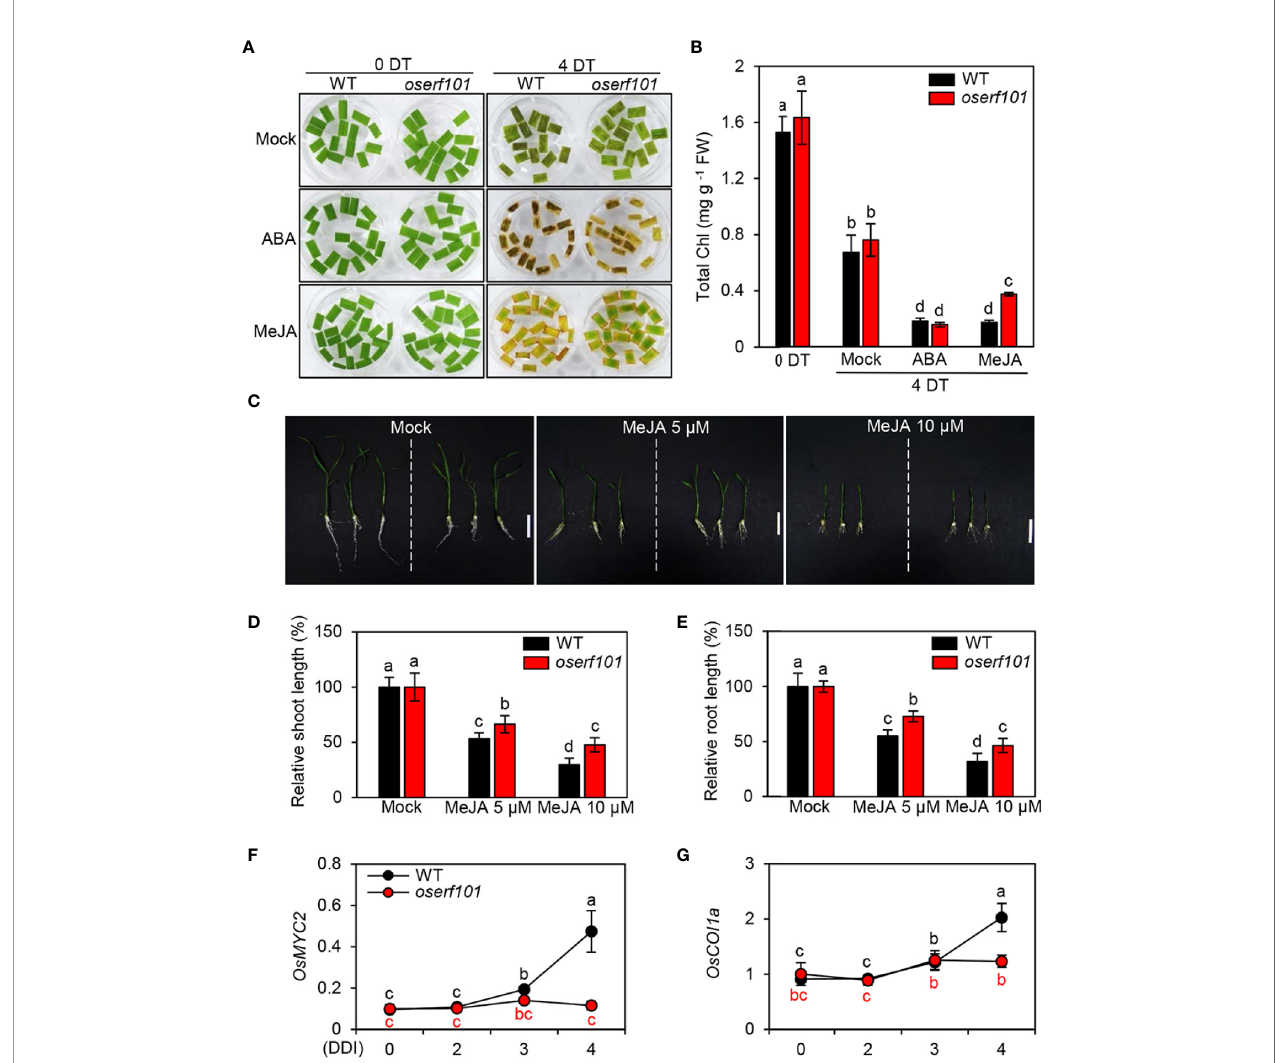
FIGURE 4 | Jasmonic acid (JA) hyposensitivity of the oserf101 mutants. (A, B) Detached leaves of 3-week-old WT and os erf101 plants grown in the greenhouse under natural long-day conditions (>14 h light/day) were incubated in 3 mM MES buffer (pH 5.8) containing 50 µM abscisic acid (ABA) or 50 µM methyl jasmonate (MeJA) under continuous light at 28°C. Detached leaves fl oated on 3 mM MES buffer (pH 5.8) without phytohormones were used as a mock control. The MeJA hyposensitive phenotype (A) and total chlorophyll (Chl) contents (B) were observed at 0 and 4 days after treatment (DT). (C – E) The WT and oserf101 seeds germinated in half-strength Murashige and Skoog (1/2 MS) solid medium for 3 d were grown in 1/2 MS solid medium containing 5 or 10 µM MeJA for 10 d under long-day (LD) conditions (14 h light at 30°C/10 h dark at 25°C). Seedlings grown in 1/2 MS solid medium without MeJA were used as a mock control. The growth phenotype (C) and relative shoot (D) and root (E) length were observed ( n = 10). (F, G) Altered expression of MeJA signaling genes OsMYC2 and OsCOI1a in detached leaves of 3-week-old WT and oserf101 seedlings during DIS. Total RNA was isolated from detached leaves at 0, 2, 3, and 4 DDI as shown in Figure 3A . The transcript levels of OsMYC2 (F) and OsCOI1a (G) were determined by qRT-PCR and normalized to that of OsUBQ5 (Os01g22490). Mean and standard deviations were obtained from at least three biological samples. Different letters indicate signi fi cantly different values according to a one-way ANOVA and Duncan ’ s least signi fi cant range test ( p < 0.05). FW, fresh